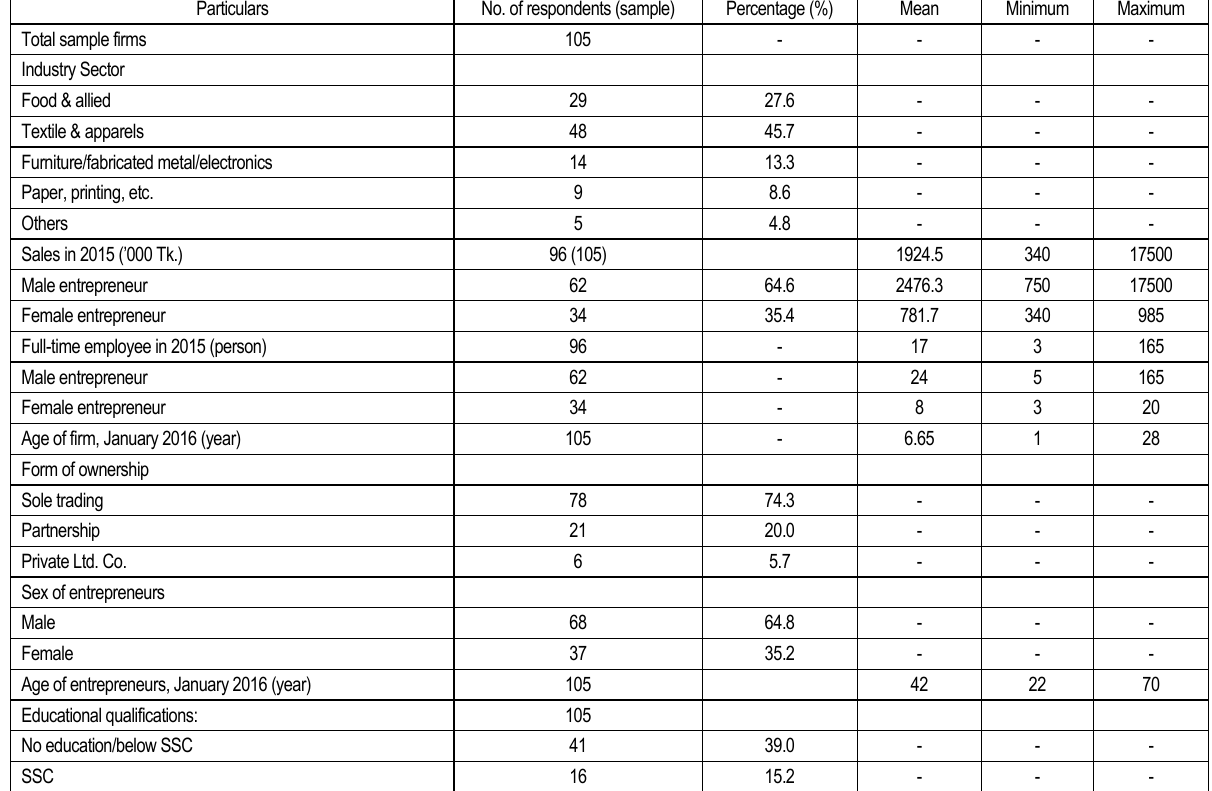
Table 2. Information about entrepreneurs